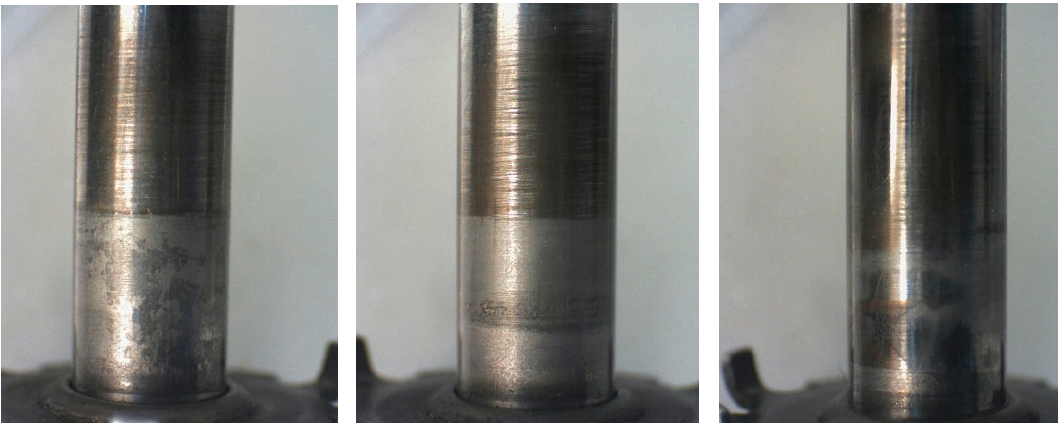
Figure 18. Magnified view (10×) of the clean pump plungers.